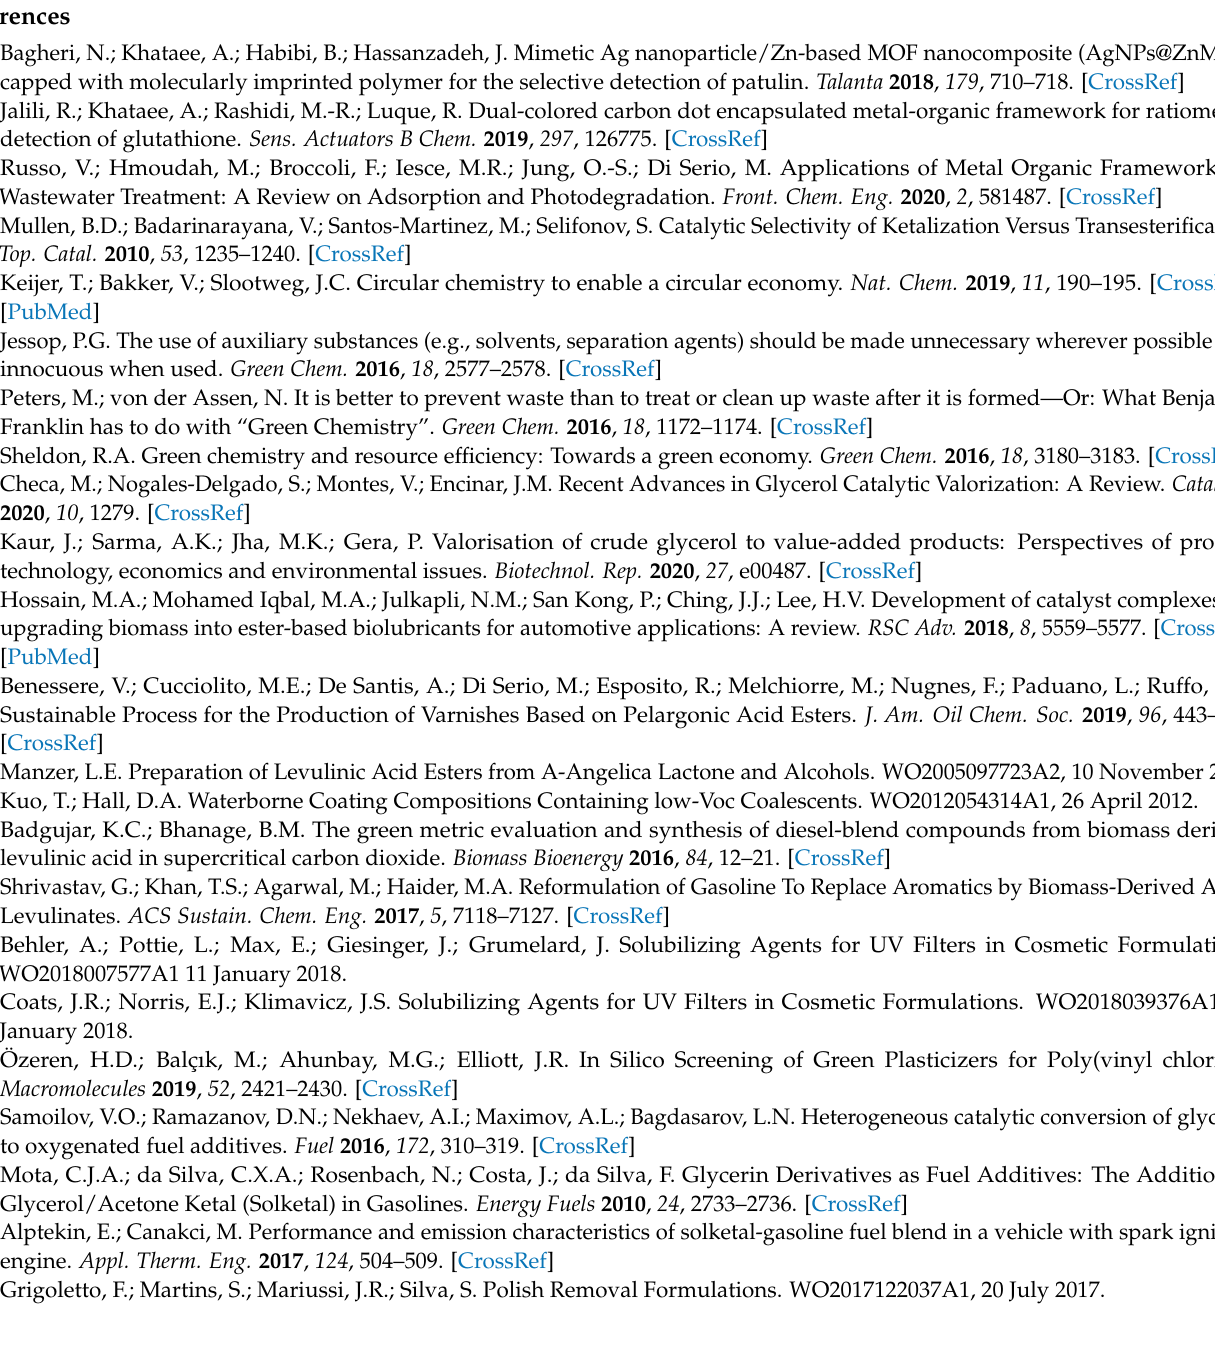
Sample Availability: Samples of the compounds MIL-88A, ethyl 3-(4-(hydroxymethyl)-2-methyl-1,3- dioxolan-2-yl)propanoate are available from the